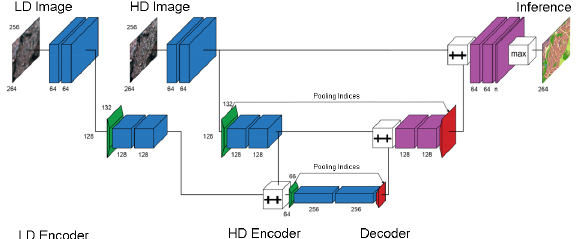
Figure 2. Proposed architecture for fusion. Same color legend as figure